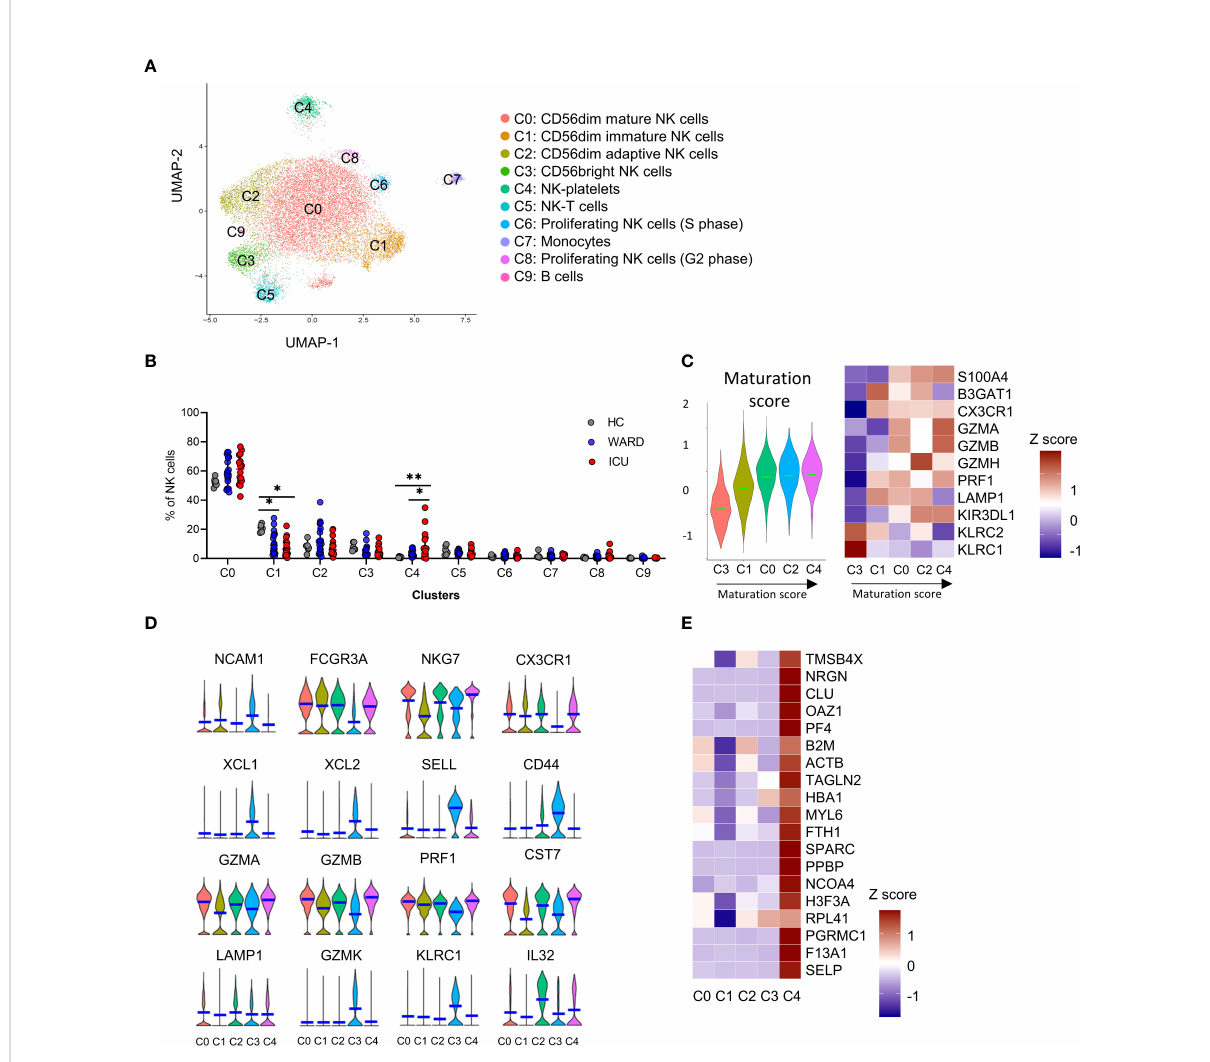
FIGURE 6 Single-cell RNA-sequencing reveals 10 distinct NK cell subsets. (A) UMAP representation of 16560 sub-clustered natural killer (NK) cells [obtained from peripheral blood mononuclear cells (PBMCs) from healthy controls (HCs) (n = 6), WARD patients (n = 16) and ICU patients (n = 16)] by scRNA-seq, colour-coded for the indicated cell type. (B) The relative contribution of each NK cell type (in %) in HCs, WARD, and ICU COVID-19 patients. (C) Heatmap of maturation-related genes and representative score in the different clusters. (D) Violin plots of key NK cells marker genes in the different subclusters. (E) Heatmap of main platelet-related genes. P-values were obtained using Wilcoxon signed-rank test with Bonferroni correction. *p<0.05;